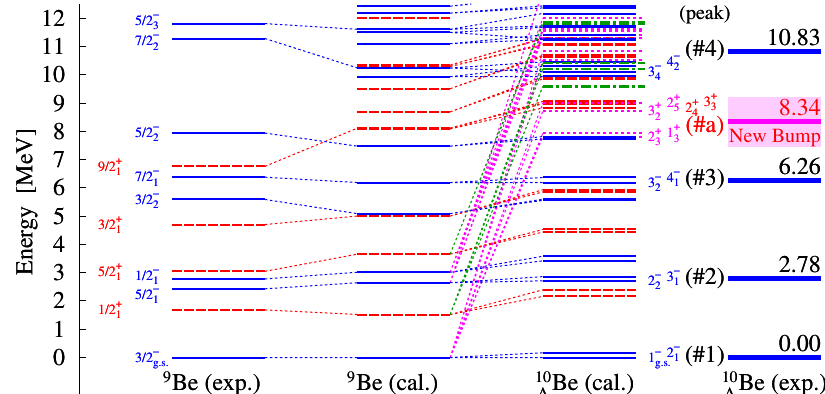
Figure 1. Energy levels for the low-lying states of 10 Λ Be together with the 9 Be core nucleus. The columns 2 and 3 show our results, and the columns 1 and 4 show the experimental data [2]. In the column 3, the spin-parities are labeled for dominant states produced by the ( γ, K + )